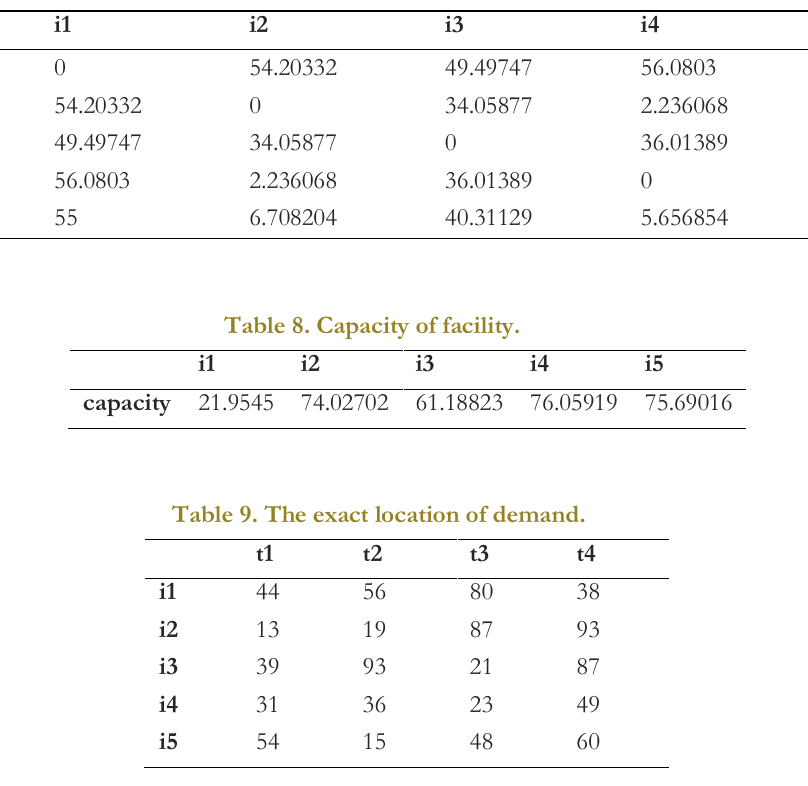
Table 7. Volume and capacity of path demand and distance between exact demand point.